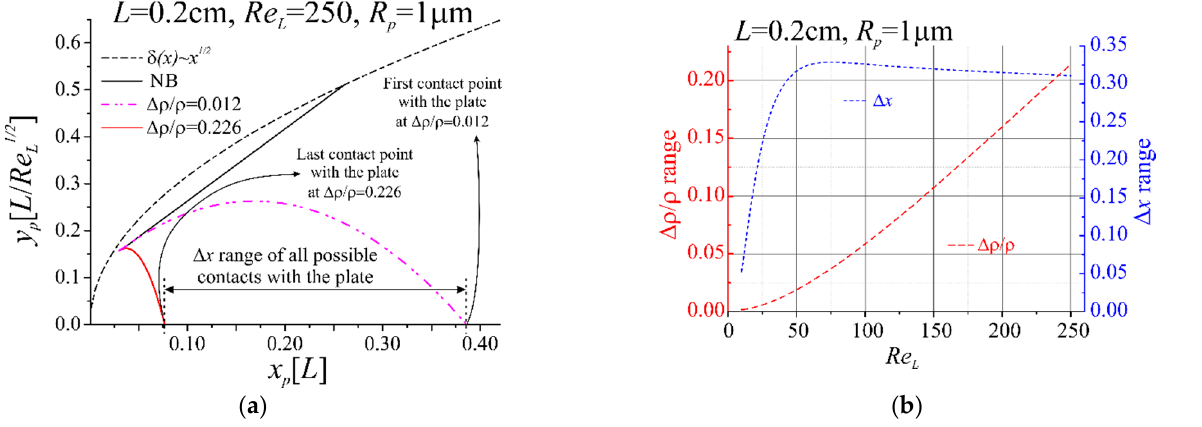
Figure 11. Entrapment of small light particle with R p = 1 μ m at a plate of L = 0.2 cm. ( a ) Particle trajectories for various relative densities, at Re L = 250; NB means neutrally buoyant sphere. ( b ) The effect of Δρ / ρ at various Reynolds numbers Re L .